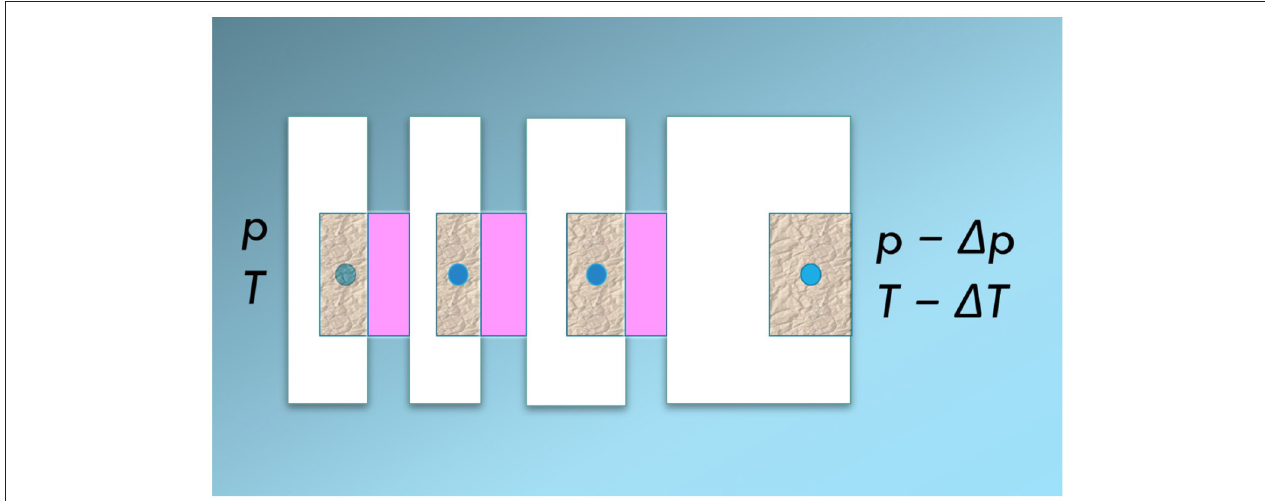
FIGURE 5 | A one-dimensional heterogeneous system cut into slices. Each cut is brought in equilibrium with a homogeneous (pink) mixture at the same temperature and pressure as the